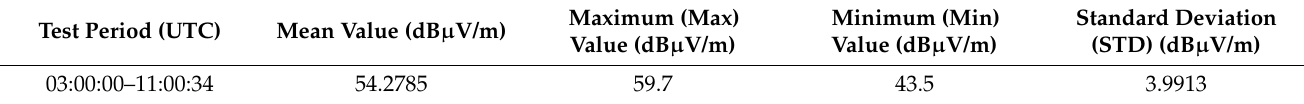
Table 2. Statistical values of the low-frequency time-code signal on 20 June 2020.